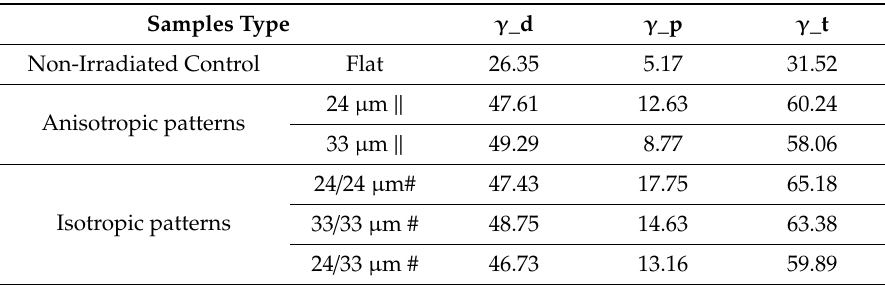
Table 1. Surface energy values of the textured